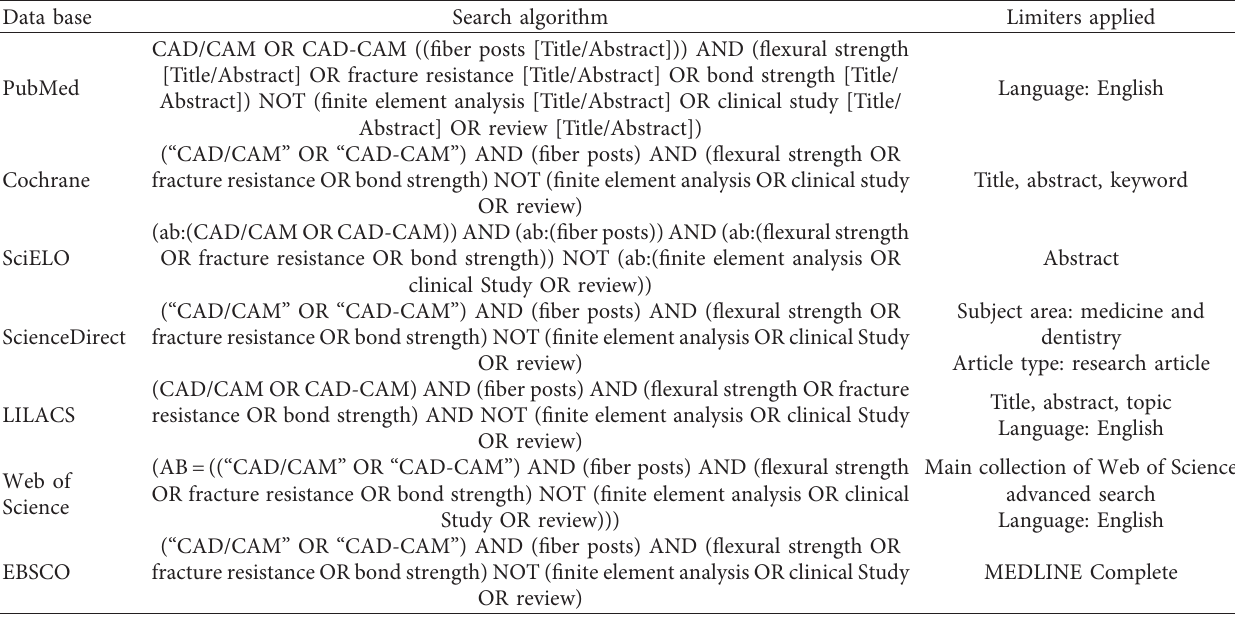
Table 1: Search algorithms in the different